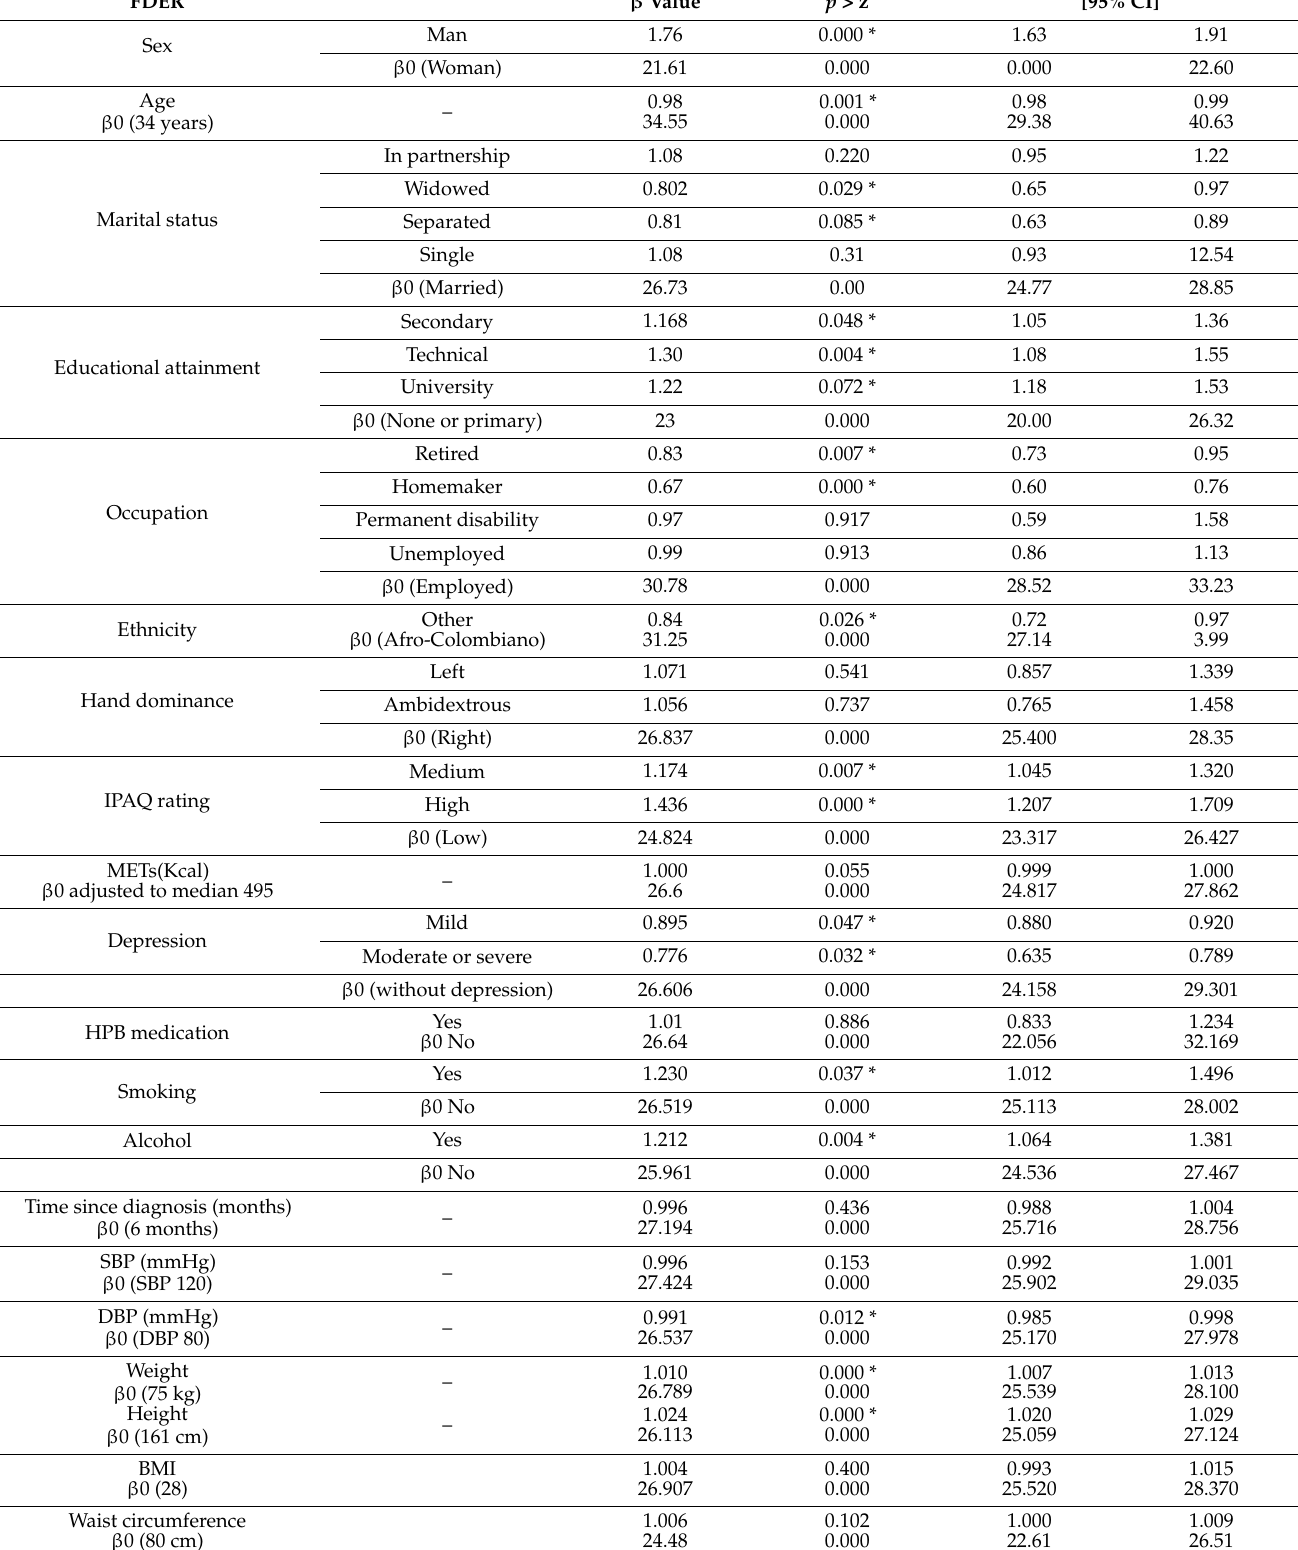
Table 3. Association between handgrip strength and each sociodemographic and clinical variable (bivariate